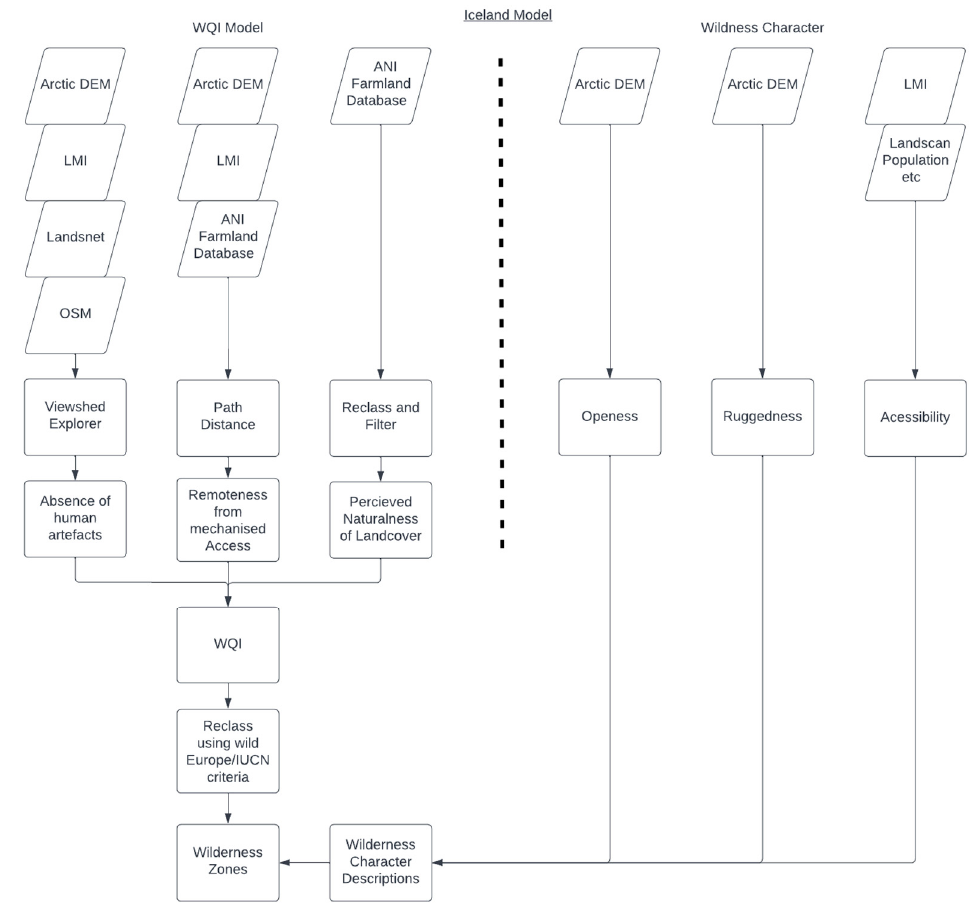
Figure 2. Model flow